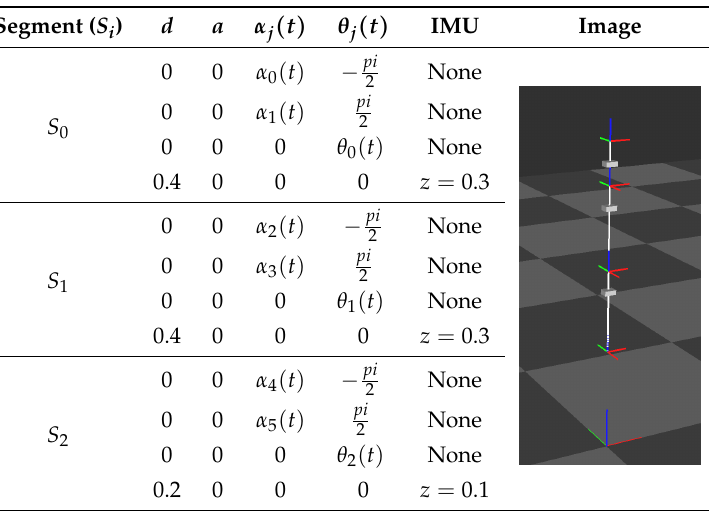
Table 5. Denavit-Hartenberg (DH) coordinates for the three segment kinematic chain model used for simulating the sim-fast-artificial data sequence. The angles α [ 0:5 ] ( t ) and θ [ 0:2 ] ( t ) are the Degrees of Freedom (DoFs) that are controlled via Equation (20). The Inertial Measurement Unit (IMU)-to-Segment (I2S) positions are given by translations along the bone, in z -direction relative to the segment origins (i.e., DH ( z ,0,0,0 ) ). The initial chain configuration (pointing up opposite gravity) is illustrated on the